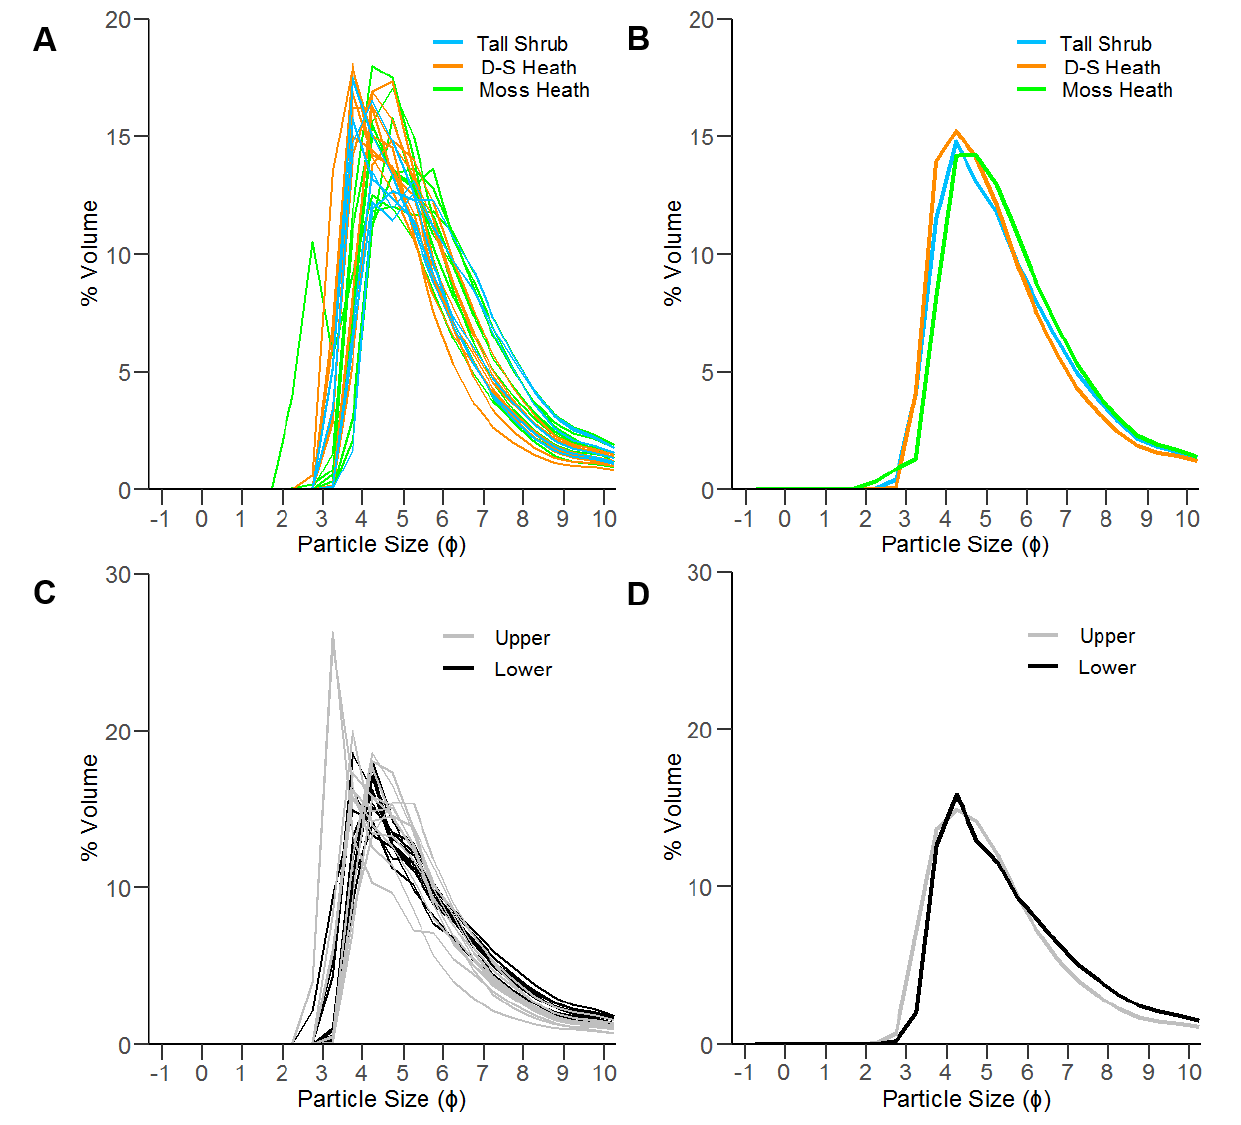
Figure 4: Grain-size distribution plots for samples of Ey2010 taken at Langanes: [A] All samples split by vegetation type (tall shrub = 12, dwarf-shrub (D-S) heath = 12, moss heath = 12), [B] Mean grain-size distributions by vegetation type, [C] Samples taken from different portions of the layer (upper = 12, lower = 12), and [D] Mean grain-size distributions for each